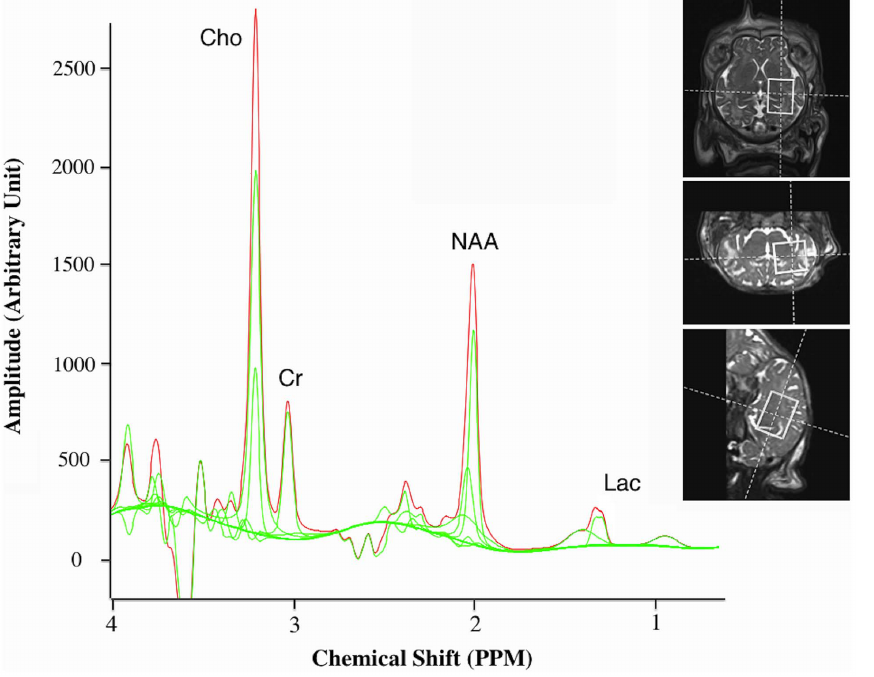
Figure 1. Magnetic resonance spectroscopy. Sample 270 ms echo time (TE) spectra from one lamb that received injurious ventilation with a representative example of voxel placement (right). Cho; choline, Cr; creatine, NAA; N-acetylaspartate, Lac; lactate. Peak ratios were determined for Lac/Cr, Lac/NAA, Lac/Cho, NAA/Cr, NAA/Cho and Cho/Cr.